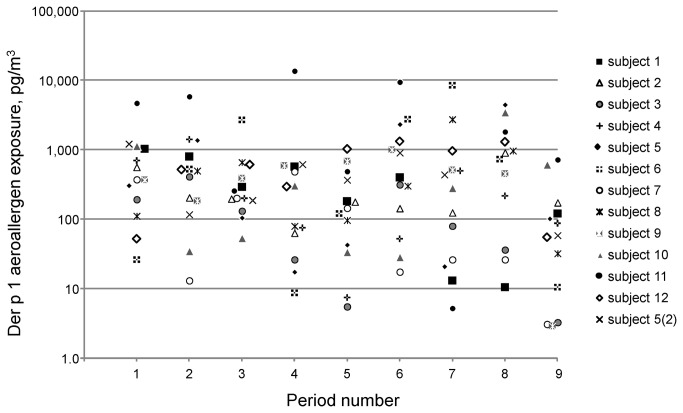
Average personal exposure (pg/m
3) for the nine sequential periods over 24 hours.
Periods 1-8 occurred over the day at approximately 2 hour intervals between 7:00am and 10:30pm and Period 9 was overnight (~8 hours). Each symbol represents a separate subject. One subject (5) who collected samples during the working week and again at the weekend is shown as subject 5(2).